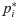
Marginal gain gi = bi − cipi as a function of pi, for i = 1, 2, 3 at time t.The dotted lines indicate the distributed participation loads pi*, and the equalized marginal gains g* that result from the iterative process shown in Fig 4.